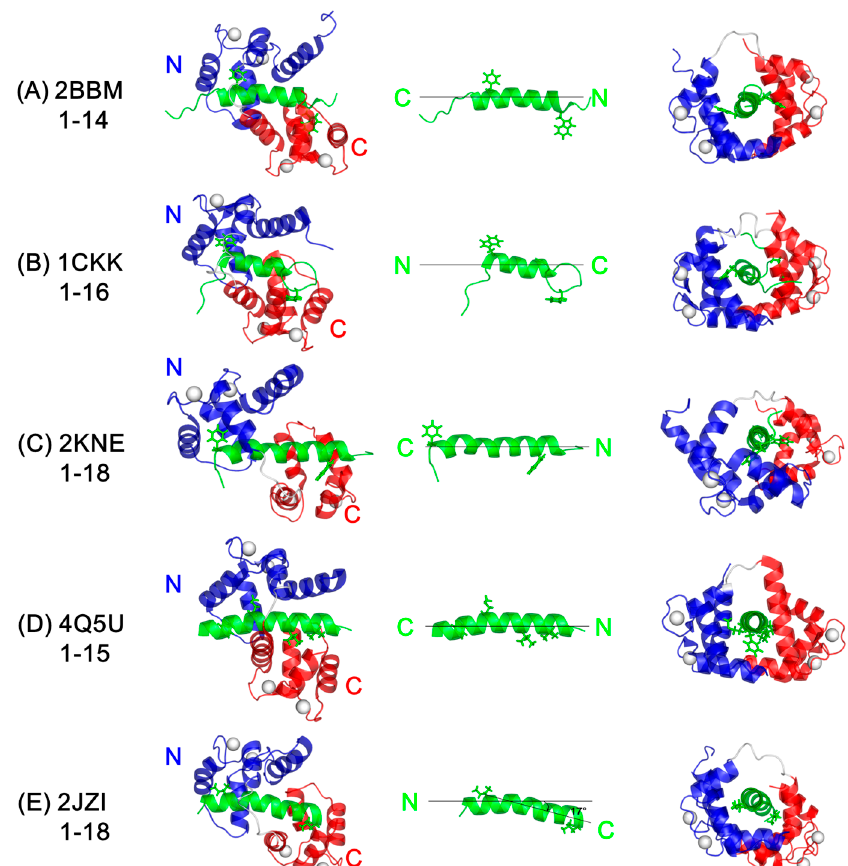
Figure 7. Comparison of relative orientation of N- and C-domain of CaM upon binding to different target peptides. ( A ) CaM and the target sequence of skeletal muscle myosin light chain kinase (PDB 2BBM); ( B ) CaM and the target sequence of CaM-dependent kinase kinase (PDB 1CKK); ( C ) CaM and the target sequence of plasma membrane calcium pump (PDB 2KNE); ( D ) CaM and CaNp in crystal form (PDB 4Q5U); ( E ) CaM and CaNp in solution form (PDB 2JZI). In order to compare the relative position of the C-domain of CaM in the structure of 2JZI, 2BBM, 1CKK, 2KNE, and 4Q5U, the